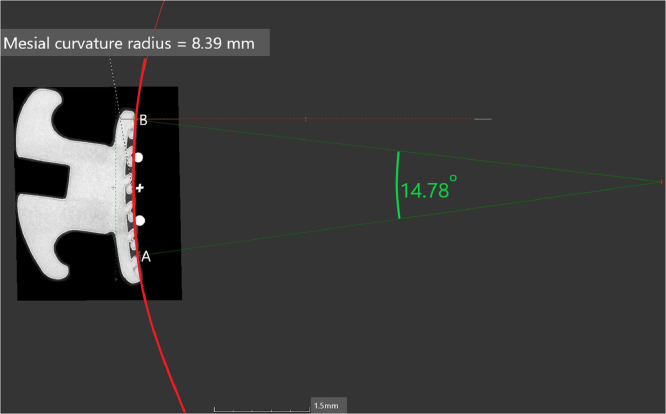
The mesial curve.